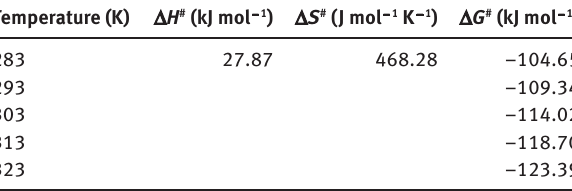
Table 4: Activation parameters for DBT catalytic oxidation.